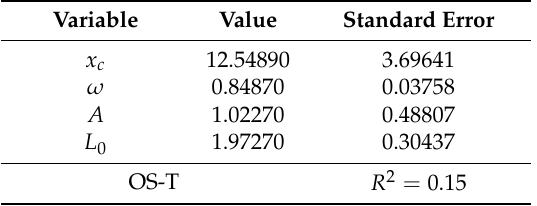
Table 16. Correlation modeling between Relative Humidity and Noise Level at OS-T.